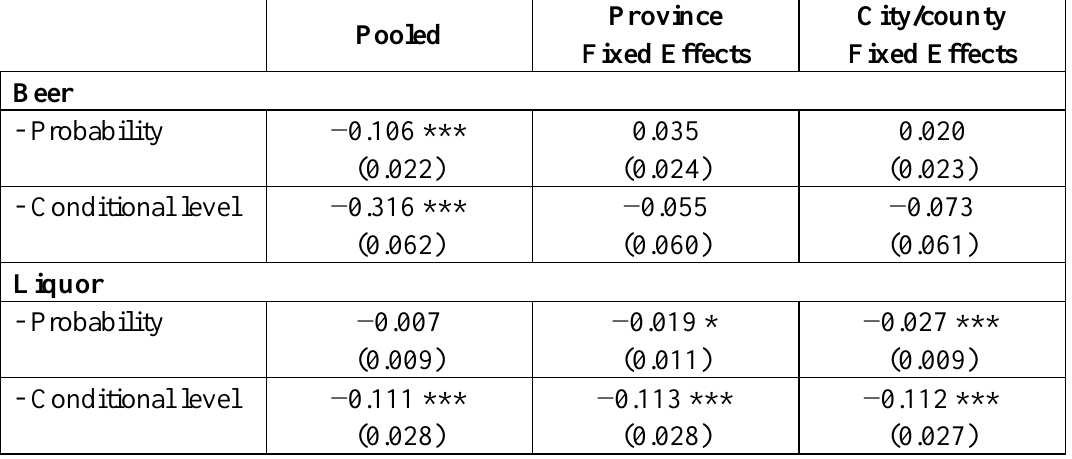
Table 3 . Price elasticities of alcohol demand in China, Men.